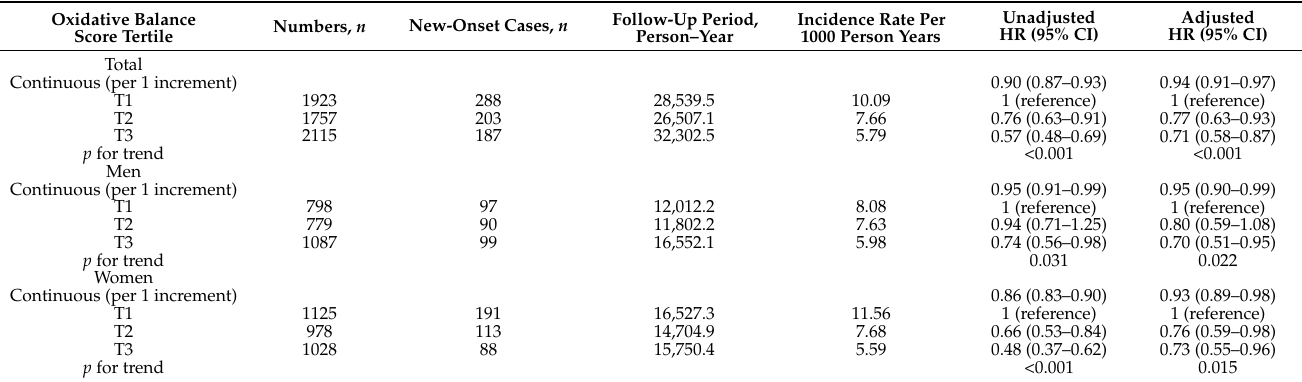
Table 4. Cox proportional hazard regression analysis showing the relationship of the oxidative balance score with incident chronic kidney disease.